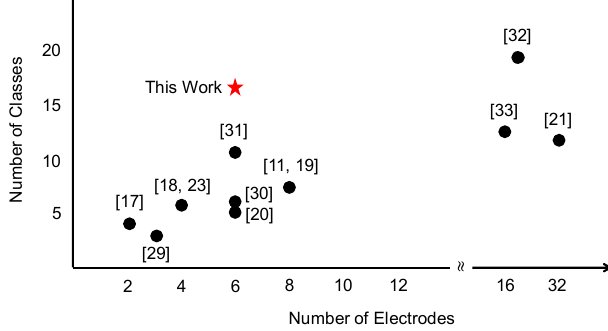
Figure 1. Overview of current electromyography (EMG) based pattern recognition studies illustrating the number of electrodes used and the number of movements classified.